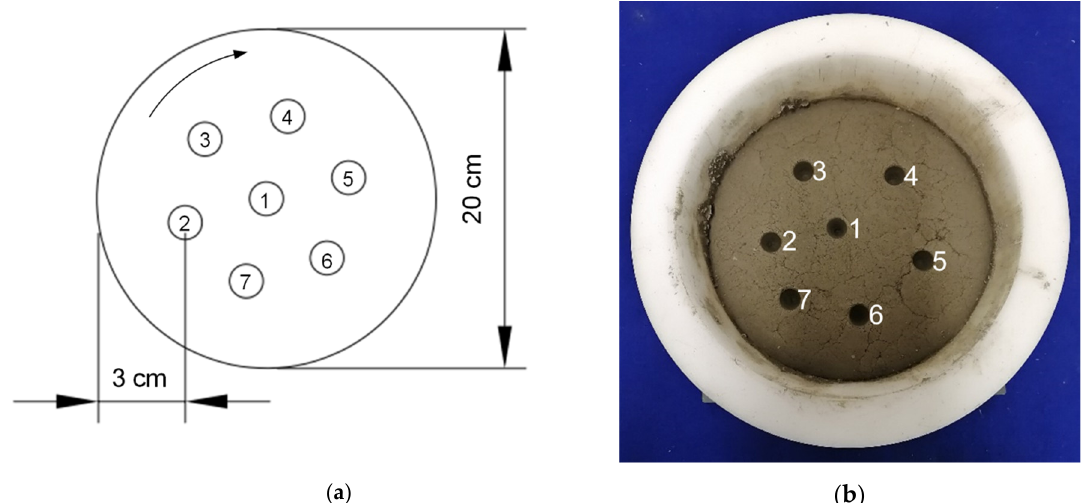
Figure 5. Arrangement of the penetration points 1–7 ( a ) and example of a fresh mortar sample tested with the 15 mm diameter sphere ( b ).